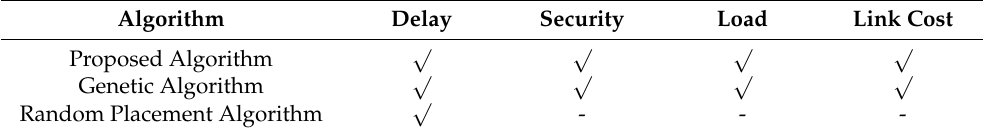
Table 3. The Parameter Settings of